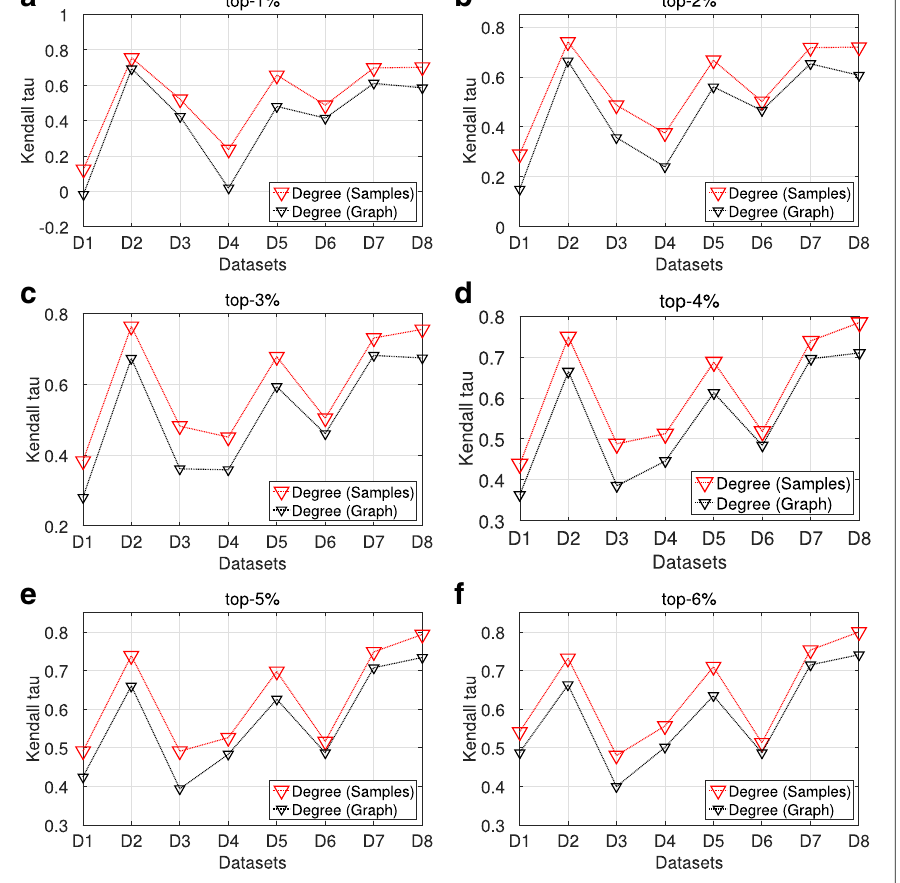
Fig. 6 Ranking similarity, SIS epidemic. a - f Average Kendall tau values in terms of degree centrality obtained from maxRD samples, along with the Kendall tau values based on degree centrality obtained from the original